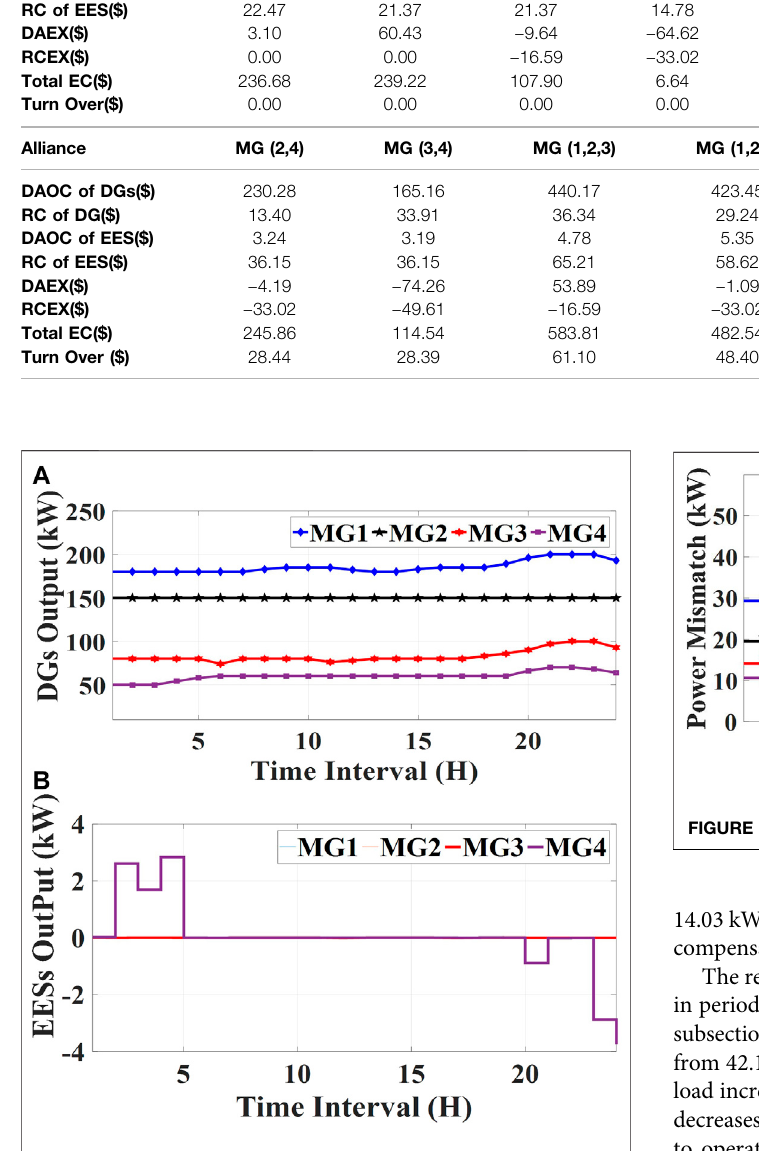
FIGURE 6 | Turnover and EC of MG coalition. subsection Figure 9 . The forecast outputs and optimal schedule values are depicted in Figures 4 , 7 . The WT output in MG1 increases from 70.2 kW (planned value) to 84.24 kW (real-time value), the load increases from 285.03 kW to 313.63 kW, and the PV output increases from 61.92 kW to 68.112 kW. The DG output increases from 182 kW to 200 kW, the ESS discharges 6.19 kW, 8.62 kW of reserve energy is purchased from MG3, and